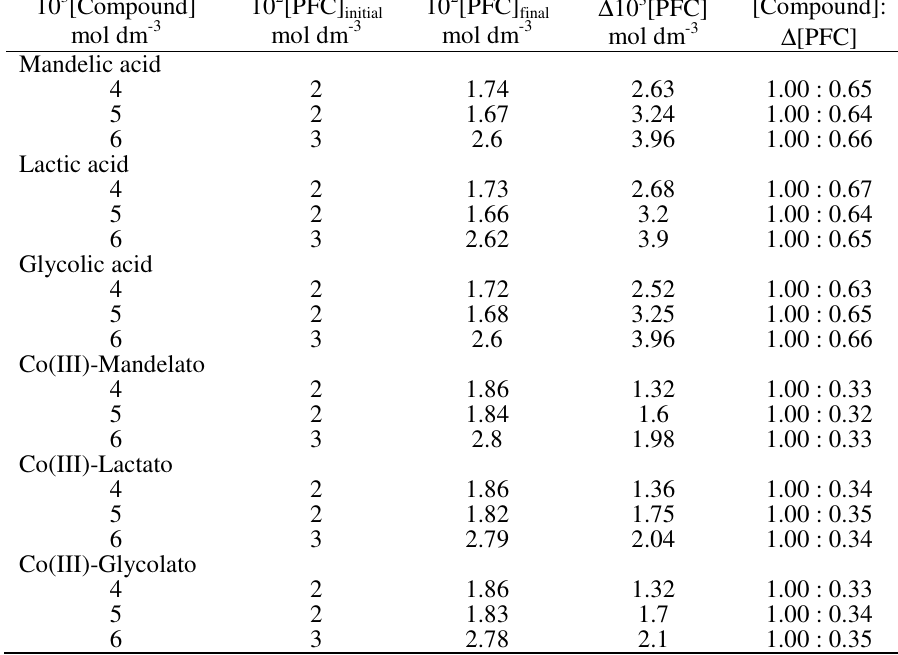
Table 1. Stoichiometric data for PFC oxidation of Co(III) bound and unbound α -hydroxy acids in presence of NaLS at 35±0.2 0